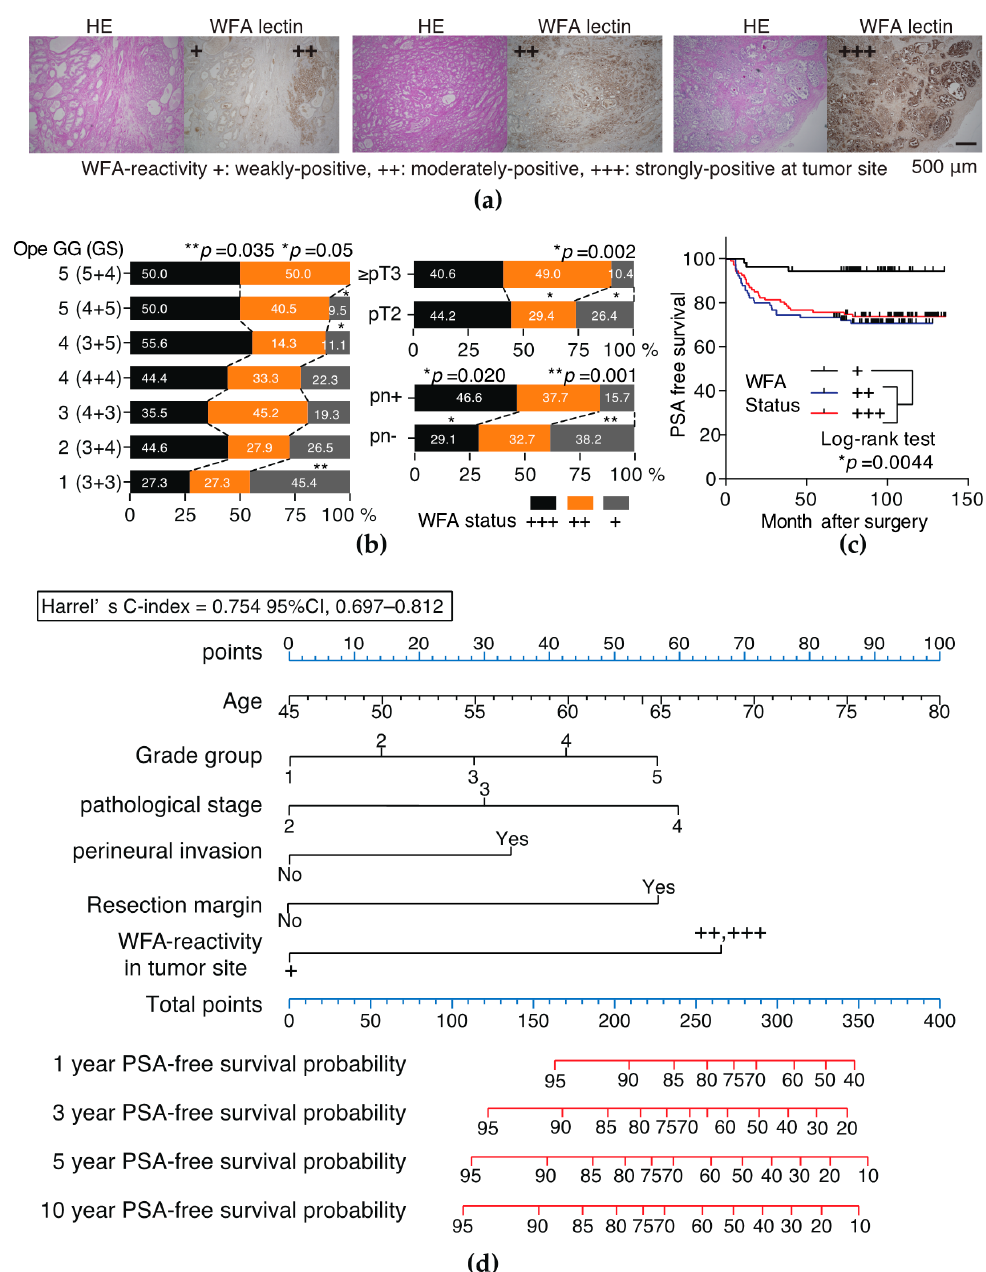
Figure 6. Immunohistochemical analysis of RP specimens using WFA lectin and post-operative nomogram predicting PSA-free survival probability. ( a ) Representative hematoxylin-eosin (HE) staining and WFA reactive-glycan expression of tumors of RP specimens. WFA-reactivity was classified into three groups: weakly positive, moderately positive, and strongly positive at a tumor site, respectively. Scale bar indicated 500 μ m; ( b ) association between with WFA-reactive glycan expression and ope GG (ope GS), pathological stage, and perineural invasion-status; ( c ) PSA-free survival was evaluated using Kaplan–Meier curves and differences between three groups were assessed using the log-rank test. Patients with tumors strongly or moderately positive for WFA had a much shorter period of PSA recurrence after RP than did patients with tumors weakly positive for WFA; ( d ) Cox hazard regression analysis-based post-operative nomogram predicting PSA-free survival probability after RP. The c-index (0.754, 95% CI, 0.697–0.812), which is similar to the area under a receiver operating characteristic curve, was used to estimate the discrimination ability of the nomogram [25].